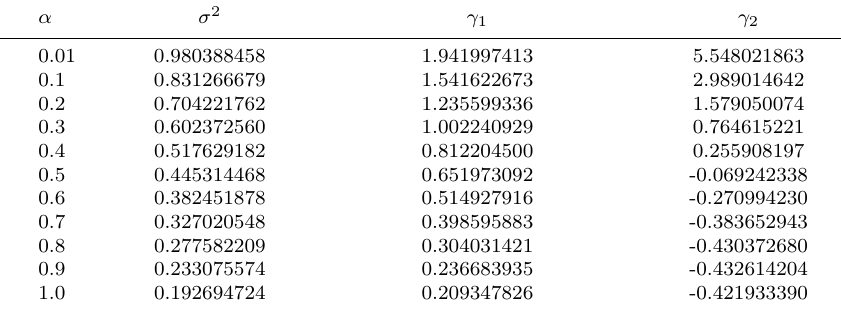
Table 1. Values of σ 2 , γ 1 and γ 2 for different values of α . α σ 2 γ